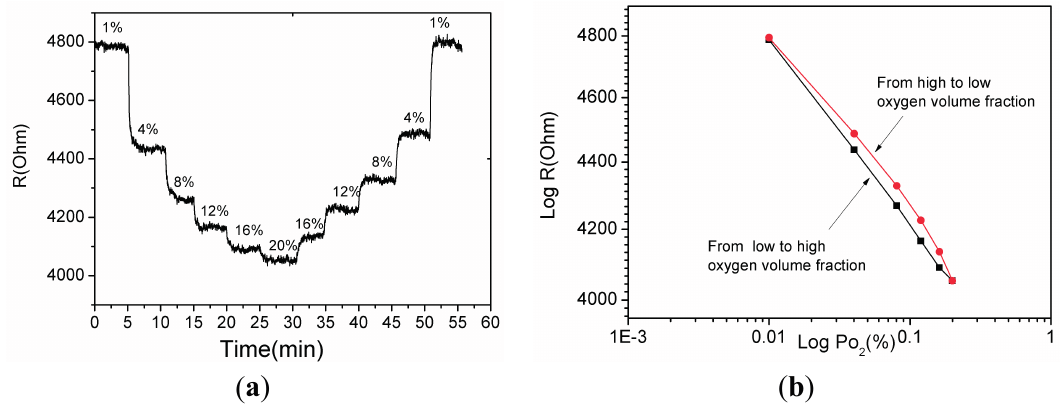
Figure 9. ( a ) The recovery response of the micro gas sensor; ( b ) The hysteresis characteristics of the micro gas sensor.